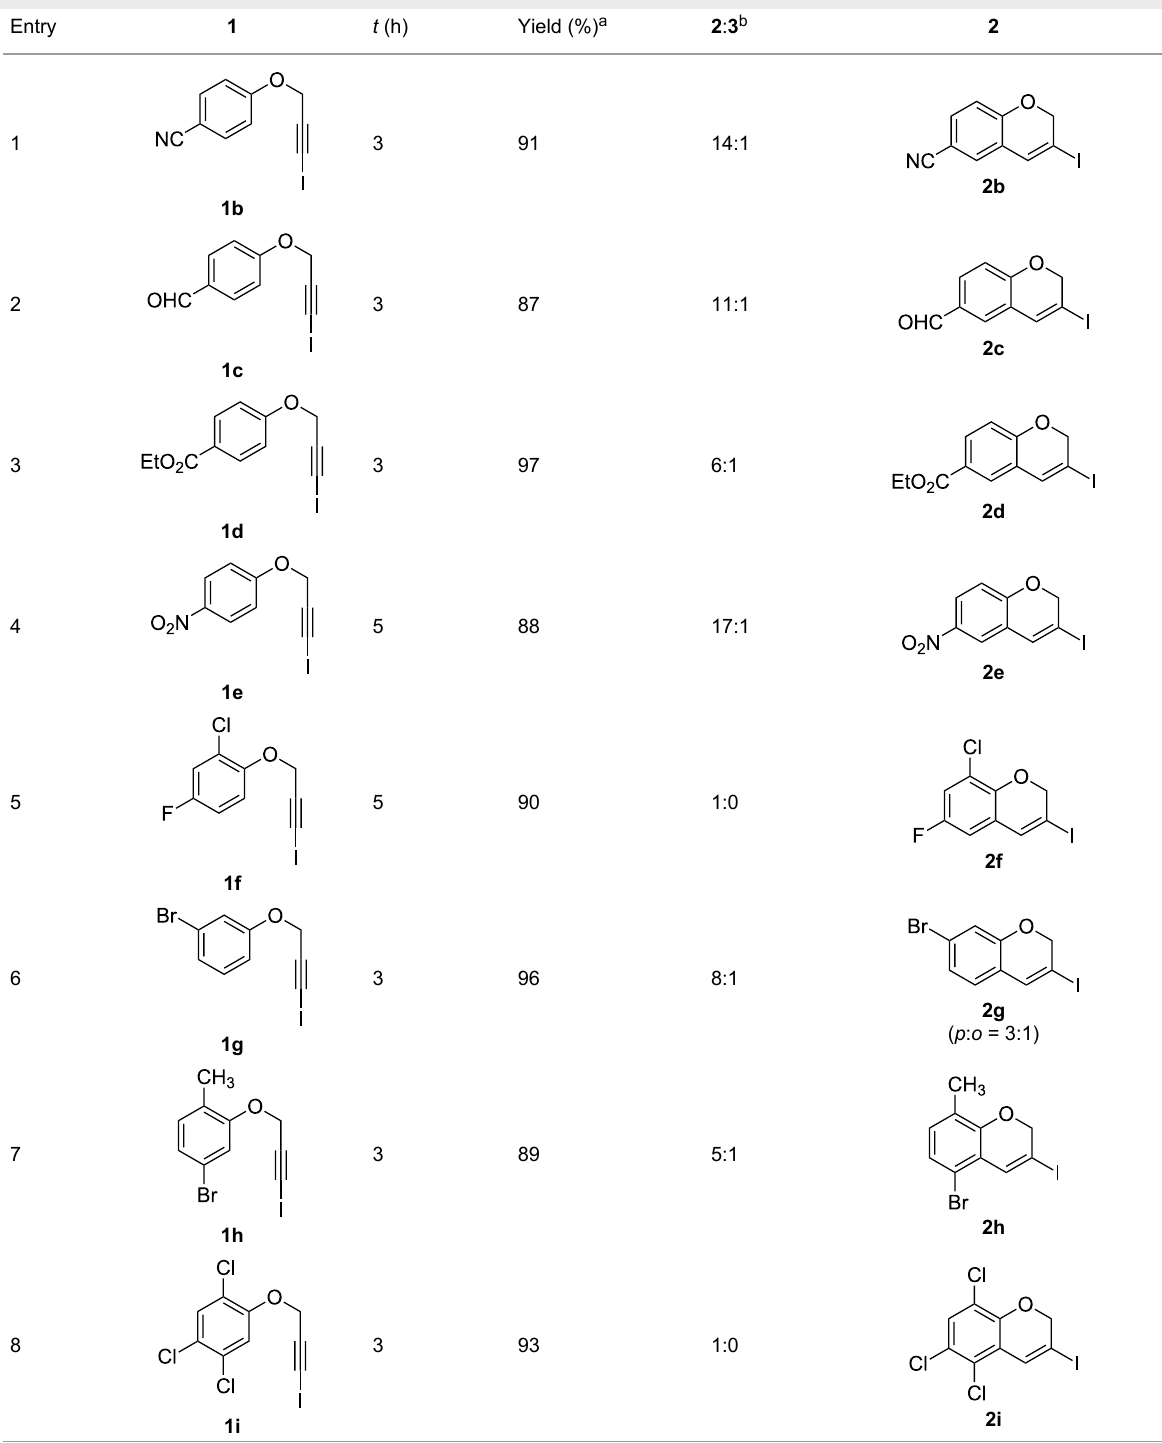
Table 2: Synthesis of 3-iodo-2 H